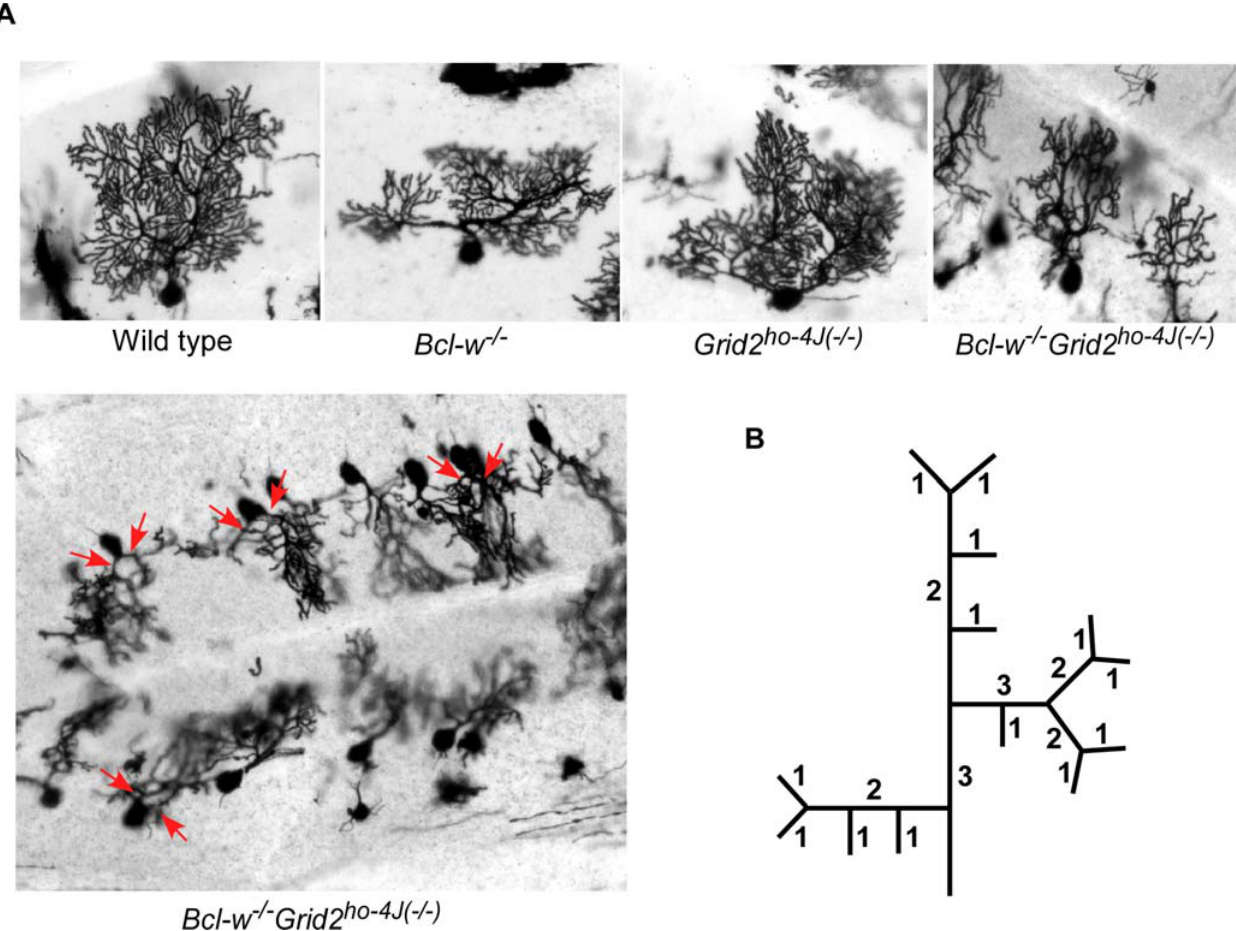
Figure 4. Golgi Stains Illustrating Dendritic Abnormalities in Bcl-w 2 / 2 Grid2 ho 2 4J( 2 / 2 ) Double Mutant Mice. (A) Golgi stain showing the profile of Purkinje cell dendritic trees in wild type, Bcl-w 2 / 2 , Grid2 ho 2 4J( 2 / 2 ) , and Bcl-w 2 / 2 Grid2 ho 2 4J( 2 / 2 ) mice (top panel). Low magnification view of one partial folia in the Bcl-w 2 / 2 Grid2 ho 2 4J( 2 / 2 ) cerebellum illustrating several affected Purkinje cells (lower panel). Red arrows indicate two primary dendritic branches extended from the Purkinje cell soma. (B) The Strahler order of method. This method was designed to assess topological features of dendrites by assigning a relative order of magnitude to each dendritic branch. The number of Strahler orders, combined with the number of branches in each of these orders, is a quantitative measure of the complexity of a dendritic tree. The tip branches are counted as ‘‘order 1’’, and two ‘‘order 1’’ branches meet to form the ‘‘order 2’’ branch, etc.